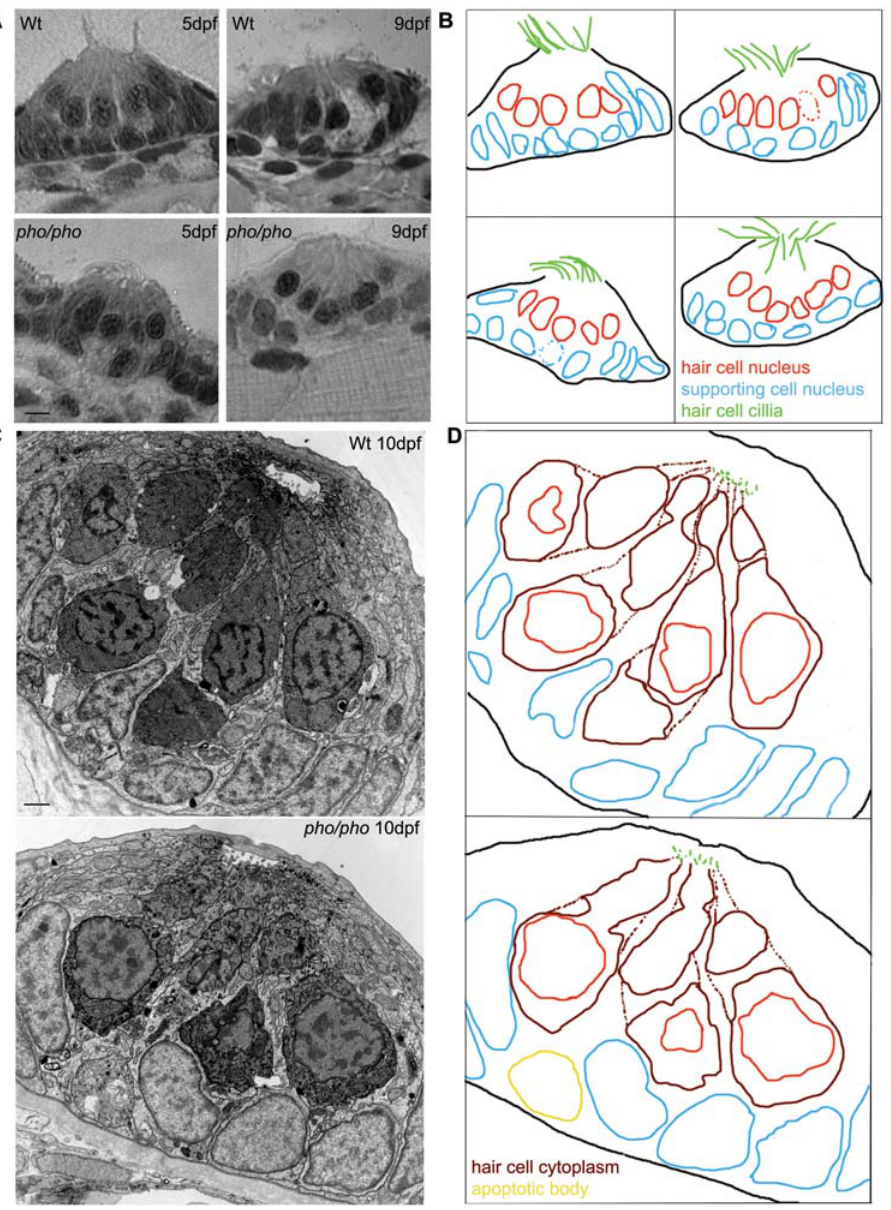
Figure 1. The development of the neuromasts in the lateral line is normal in the phoenix mutant larvae. (A) Semi-thin sections showing wild-type (top panels) and mutant neuromasts (bottom panels) in 5dpf (left panels) and 9dpf (right panels) larvae. (B) Camera lucida drawing for each section, highlighting the hair cells nuclei (red) and their cilia (green) and the supporting cells nuclei (blue). (C) Ultra-thin sections viewed by Electron Microscopy (EM) of a wild-type (top panel) and a mutant (lower panel) neuromast in 10dpf larvae. The hair cells stain darker than the supporting cells. (D) Camera lucida drawings of the EM sections, highlighting the hair cell nuclei (red), cell bodies (dark red), and cilia (green). The nuclei of the supporting cells are highlighted (blue). One apoptotic body was visible in (yellow). – 5 microns in (A) and 1 micron in